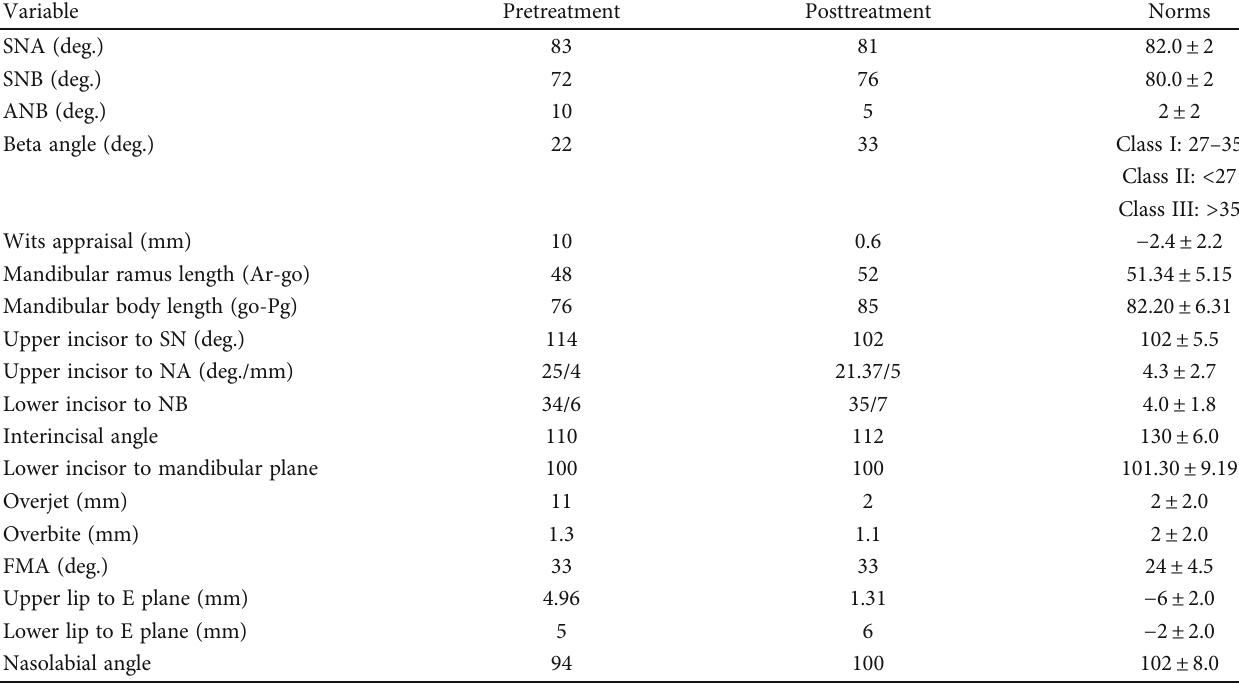
Table 1: Comparing pretreatment and posttreatment cephalometric